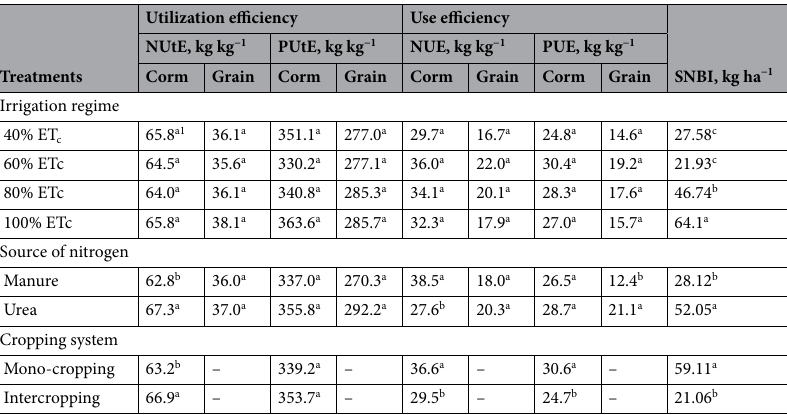
Table 10. Means for nitrogen and phosphorus utilization efficiencies (NUtE and PUtE, respectively), nitrogen and phosphorus use efficiencies (NUE and PUE, respectively) for saffron corm and wheat grain and system nitrogen balance index (SNBI) all for the last (fourth) growing season. *Means followed by similar letters in each column for each factor and each trait are not significantly different at 5% level of probability according to Tukey